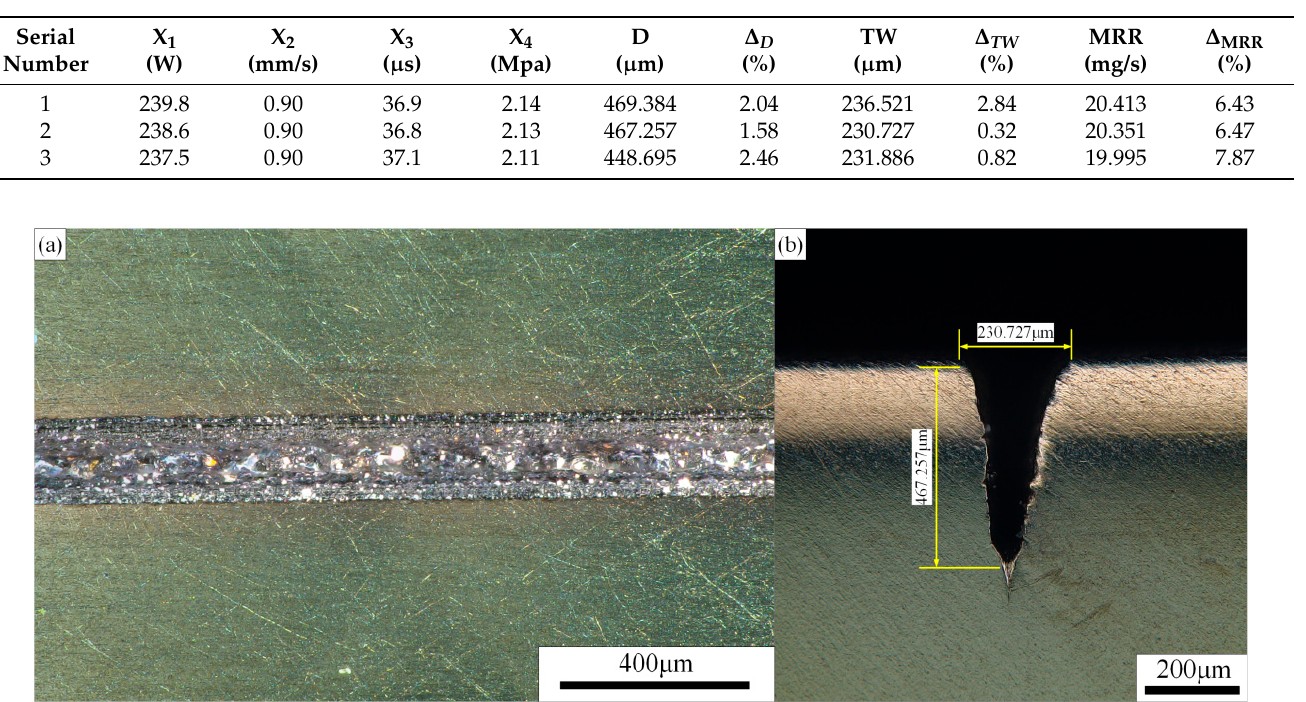
Table 12. Validation test results of optimization scheme.